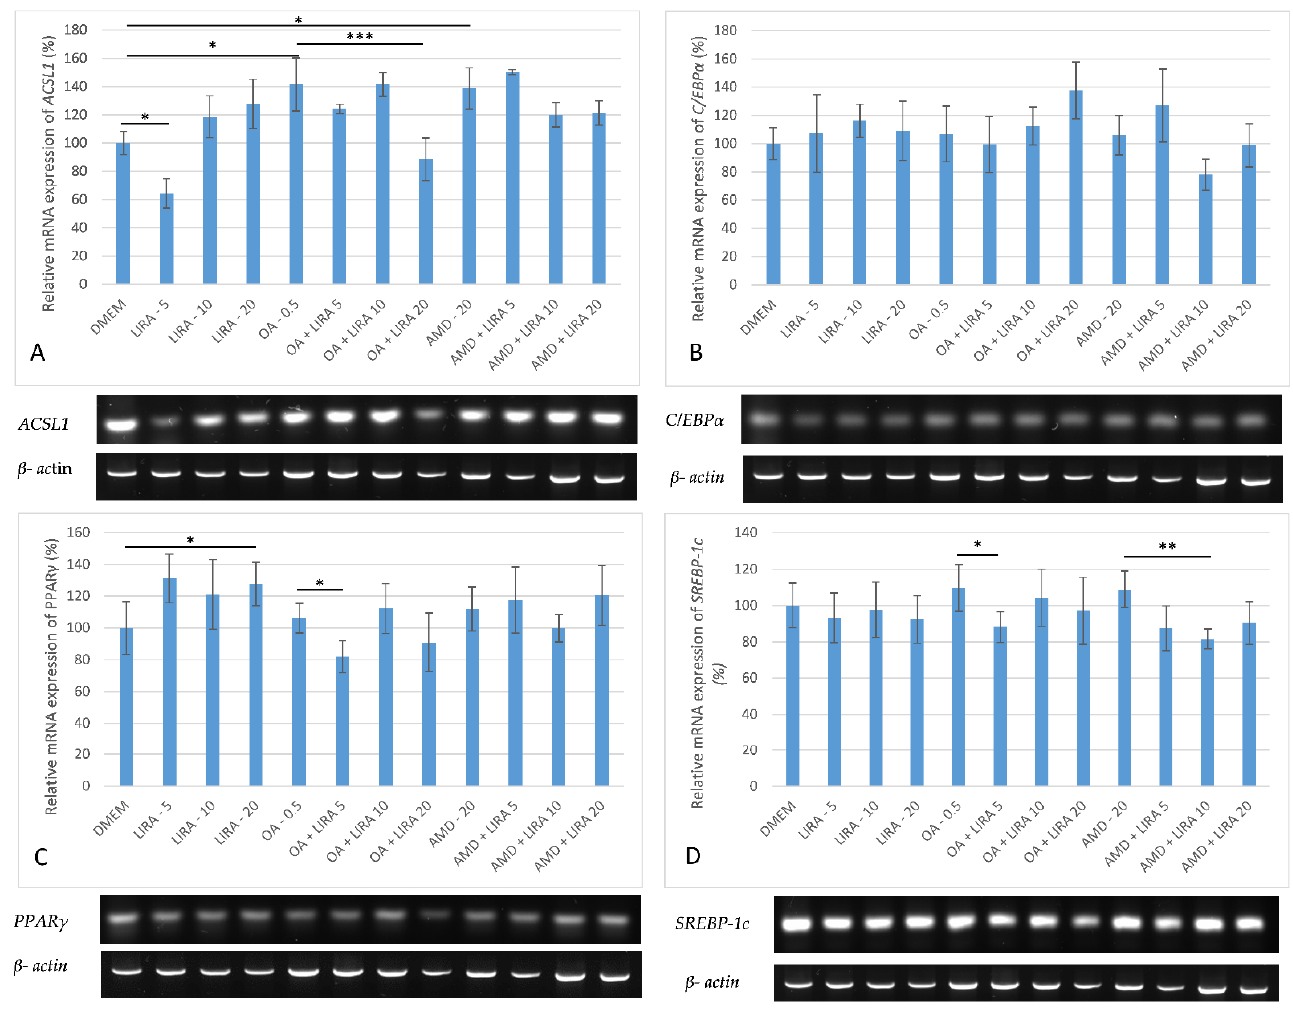
Figure 5. Expression of ACSL1, C/EBP α , PPAR γ and SREBP-1c in cell culture models of NAS and DIS. The gene expression was determined by RT-PCR. PCR results were visualized on a 1.6% agarose gel stained with Diamond™ Nucleic Acid Dye (Promega, Madison, WI, USA) according to the manufacturer’s instructions, visualized by Gel Imaging System (ChemiDocTM Imaging System, Bio-Rad, Hercules, CA, USA). The images were semi-quantified by Image Lab 6.0.1 build 34 Bio-Rad Laboratories (normalized to the housekeeping gene β -actin mRNA levels) (39). Results are shown as a percentage relative to the negative control of at least three biological replicates. ( A ) ACSL1 gene expression in Huh7 cells. One-way ANOVA F (11, 35) = 12.8 p = 1.63 × 10 − 07 post-hoc Tukey HSD